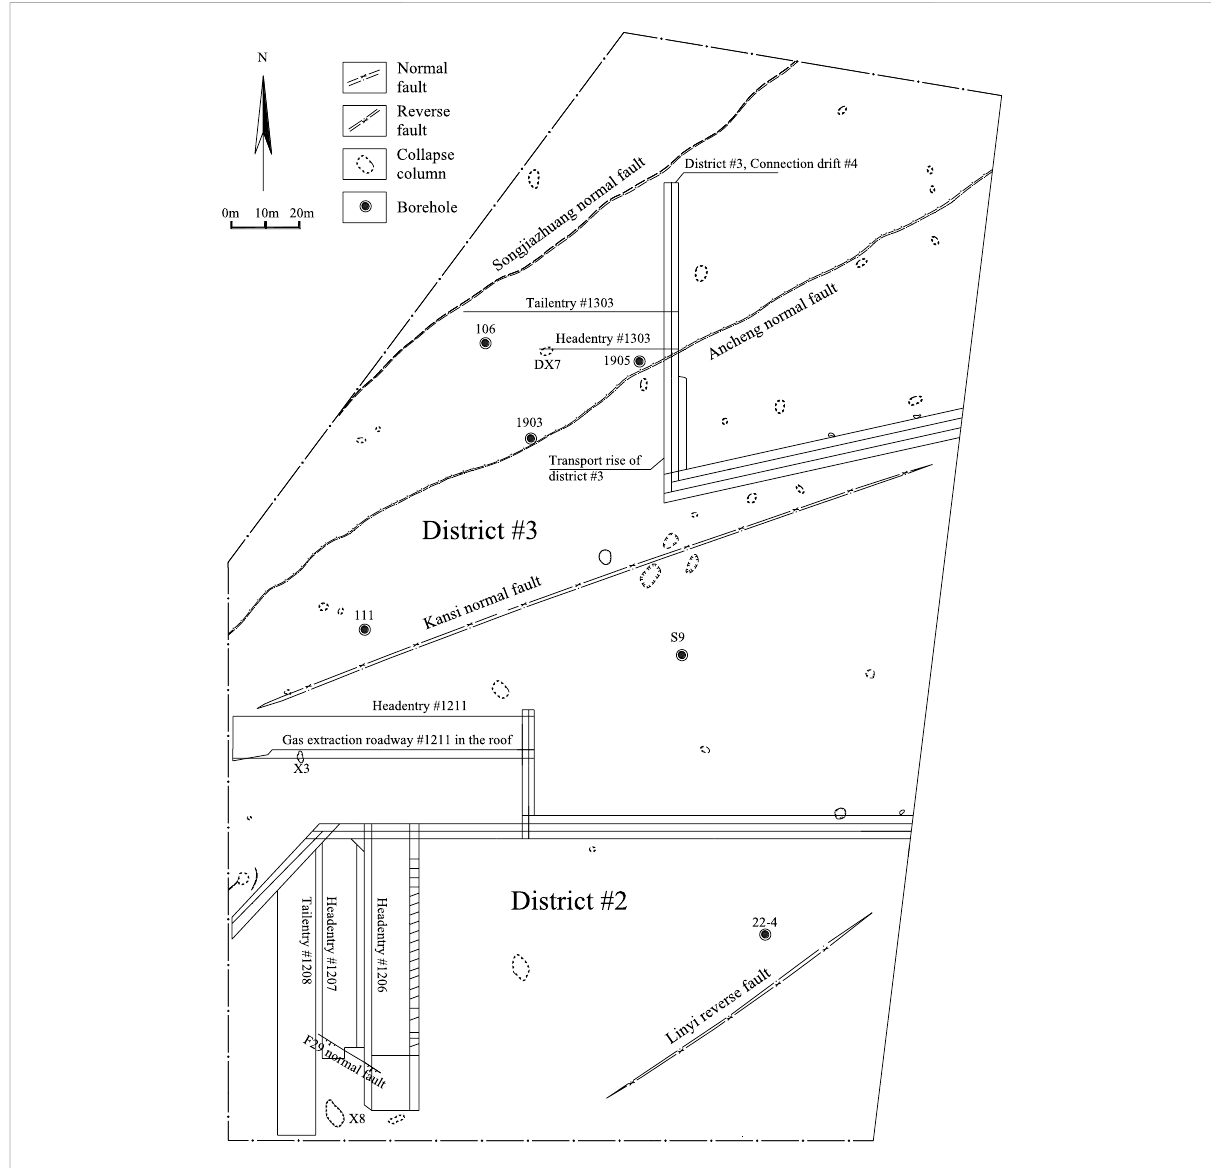
FIGURE 2 Roadway layout and main structure